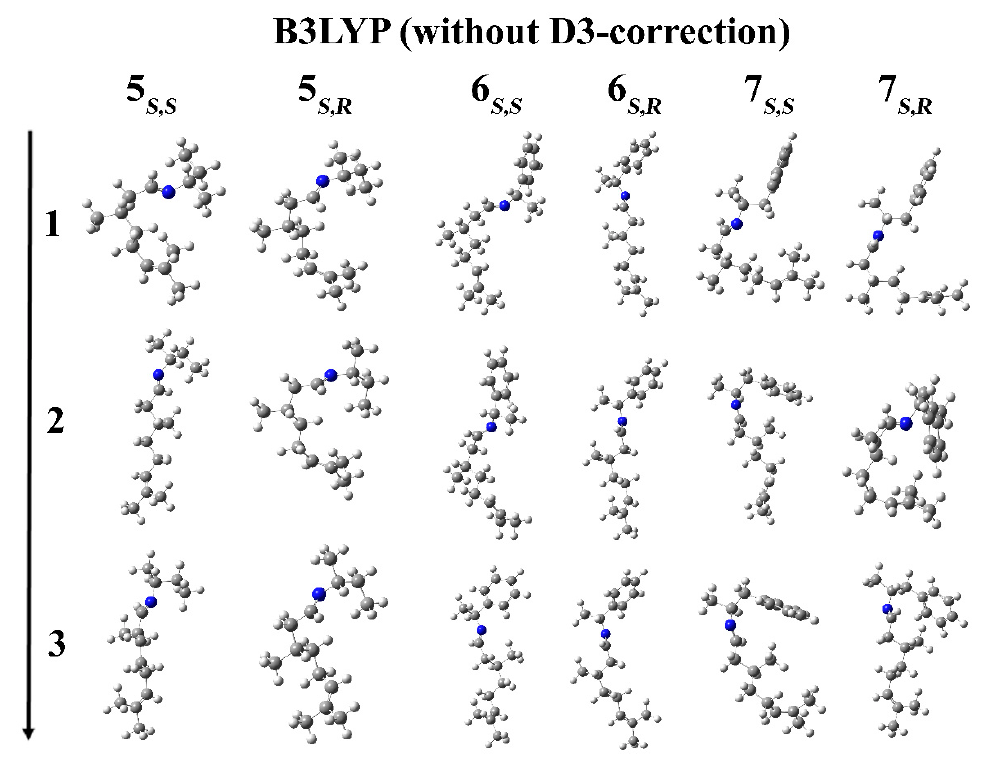
Figure 7. Most stable conformers found in imines 5, 6, and 7 after B3LYP (without